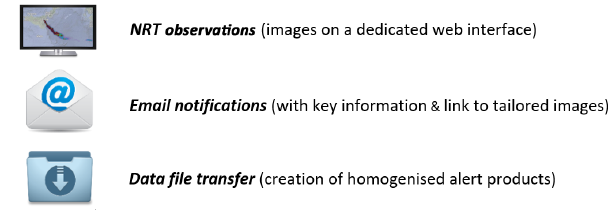
Figure 22. Overview of the three types of alert products developed by the EUNADICS-AV